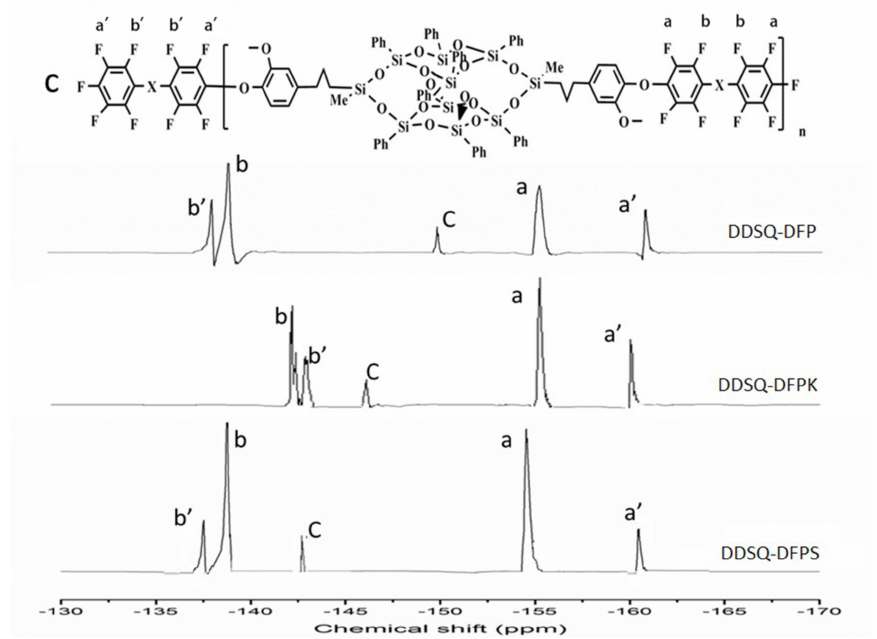
Figure 2. 19 F NMR spectra of fluorinated and terminated DDSQ-DFPXs in DMSO-d 6